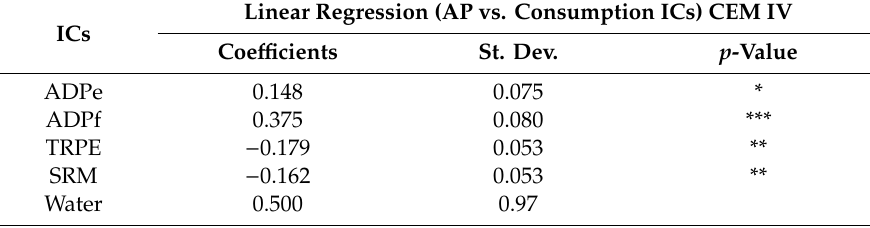
Table 24. AIC selection regression summary—CEM